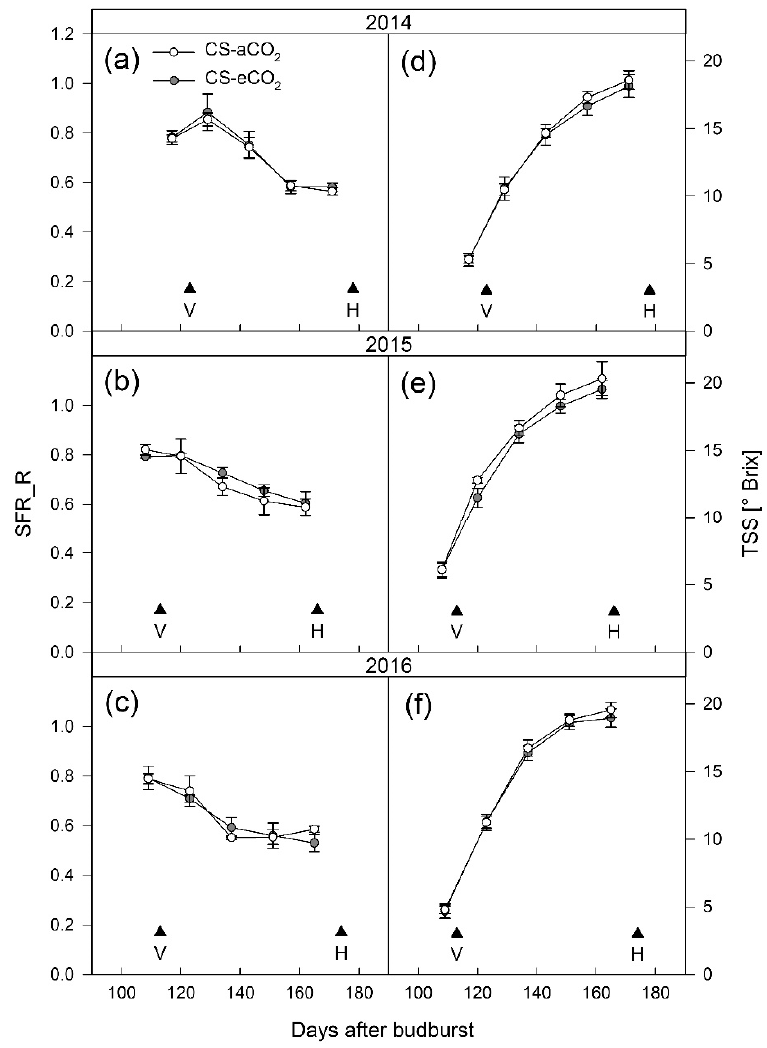
Figure 4. Chlorophyll index (SFR_R) and sugar accumulation (TSS) in aCO 2 and eCO 2 Cabernet Sauvignon berries over the three seasons 2014 ( a , d ), 2015 ( b , e ), and 2016 ( c , f ). Letters indicate seasonal development stages veraison (V) and harvest (H). Mean values per treatment ± SD of the three FACE rings.